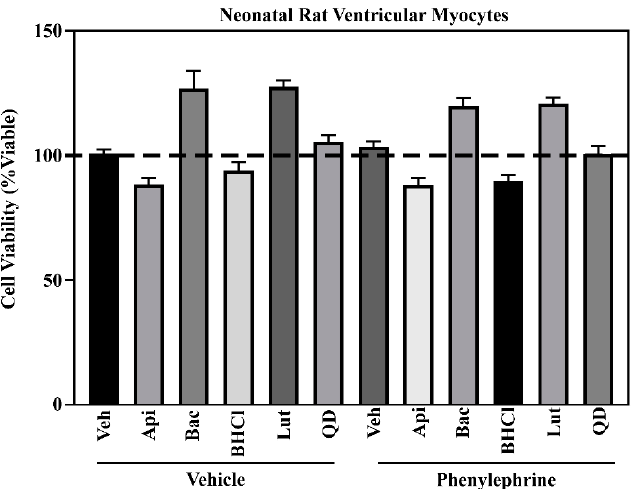
Figure 2. Phytochemical-treated NRVMs show no signs of cytotoxicity. Neonatal rat ventricular myocytes (NRVMs) were treated with the indicated phytochemicals (Apigenin (Api),